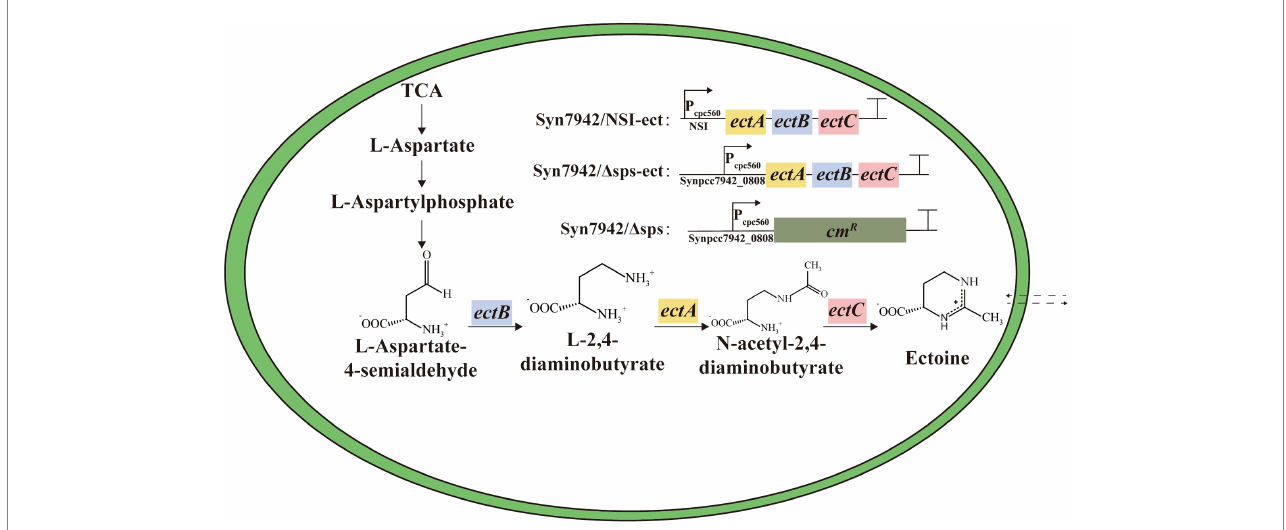
FIGURE 1 The reconstructed ectoine biosynthetic pathway in Syn7942. Syn7942/NSI-ect: indicates that the expression cassette indicated in the legend was inserted at the neutral site I (NSI); Syn7942/ Δ sps and Syn7942/ Δ sps-ect: indicate that the endogenous Synpcc7942_0808 gene was replaced using the expression cassette in the legend; TCA: indicates tricarboxylic acid cycle.